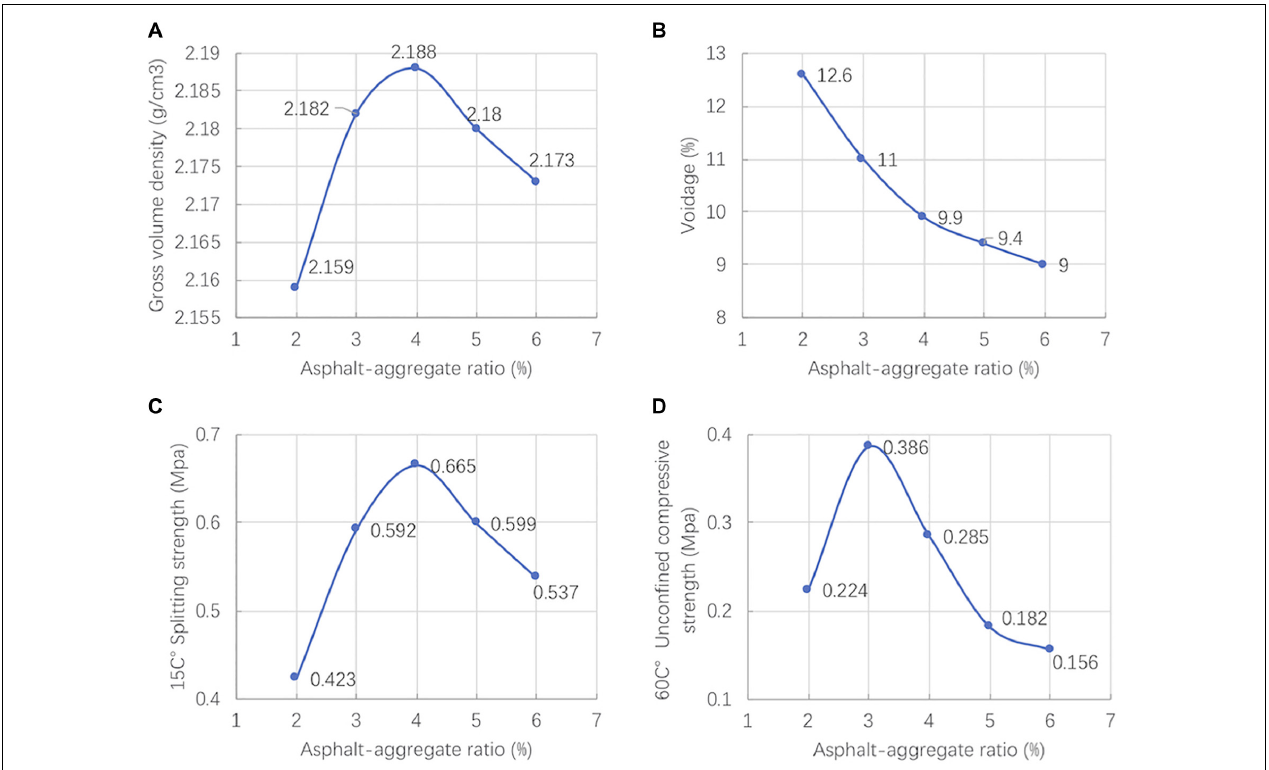
FIGURE 7 | Test results of improved design method. (A) Gross volume density (g/cm 3 ). (B) Voidage (%). (C) 15 ◦ C splitting strength (Mpa). (D) 60 ◦ C unconfined compressive strength